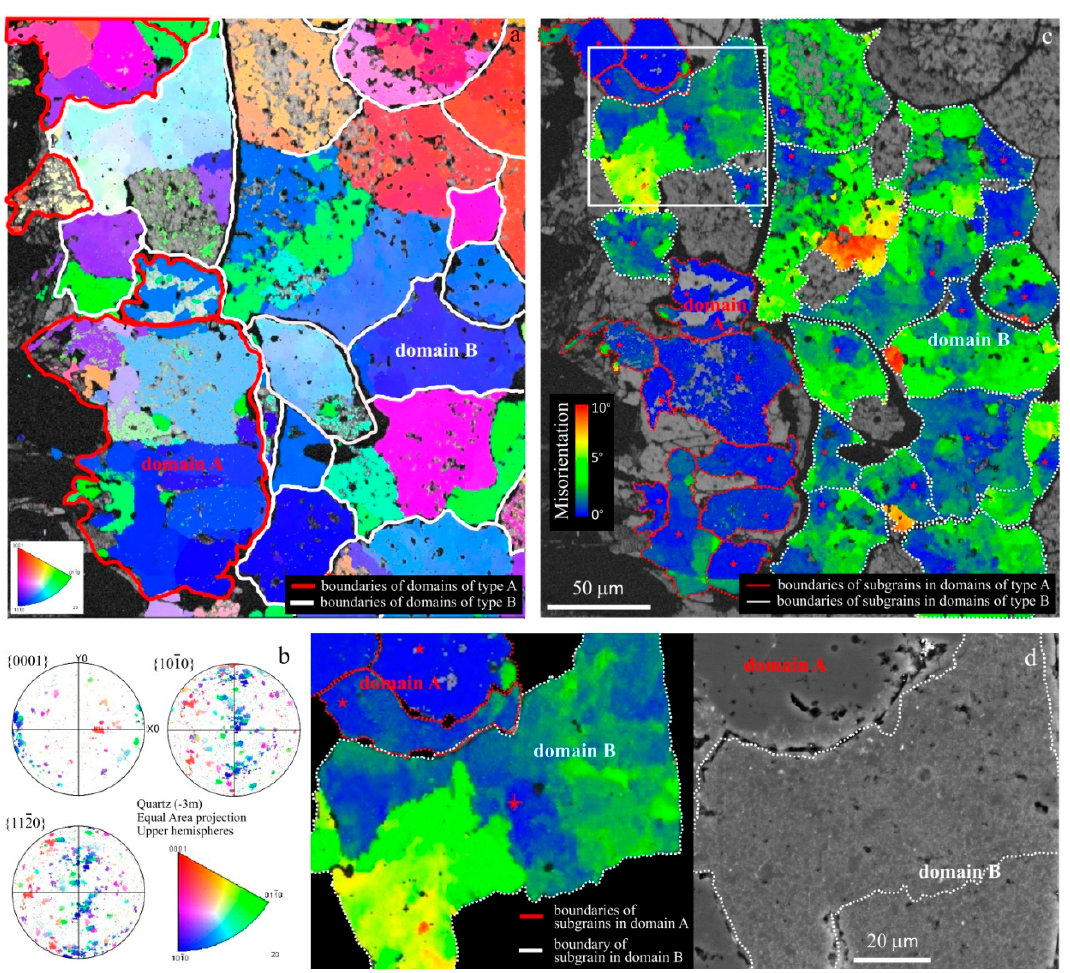
Figure 7. EBSD data characterizing an aggregate of ballen quartz. ( a ) EBSD orientation inverse pole figure map showing differently oriented subgrains in domains. Curved lines show boundaries of domains of type A (red) and type B (white). ( b ) Equal-area upper hemisphere projection pole figures for quartz, color-coded as in ( a ). ( c ) Relative misorientation EBSD map created for each subgrain in domains of type A (red dotted outline) and B (white dotted outline); user-selected reference points of misorientation maps are placed inside each subgrain (red star), and the rectangle marks the position of an enlarged area presented in ( d ). ( d ) Enlarged area of misorientation map ( c ) and BSE image showing micrometer-sized block structure.